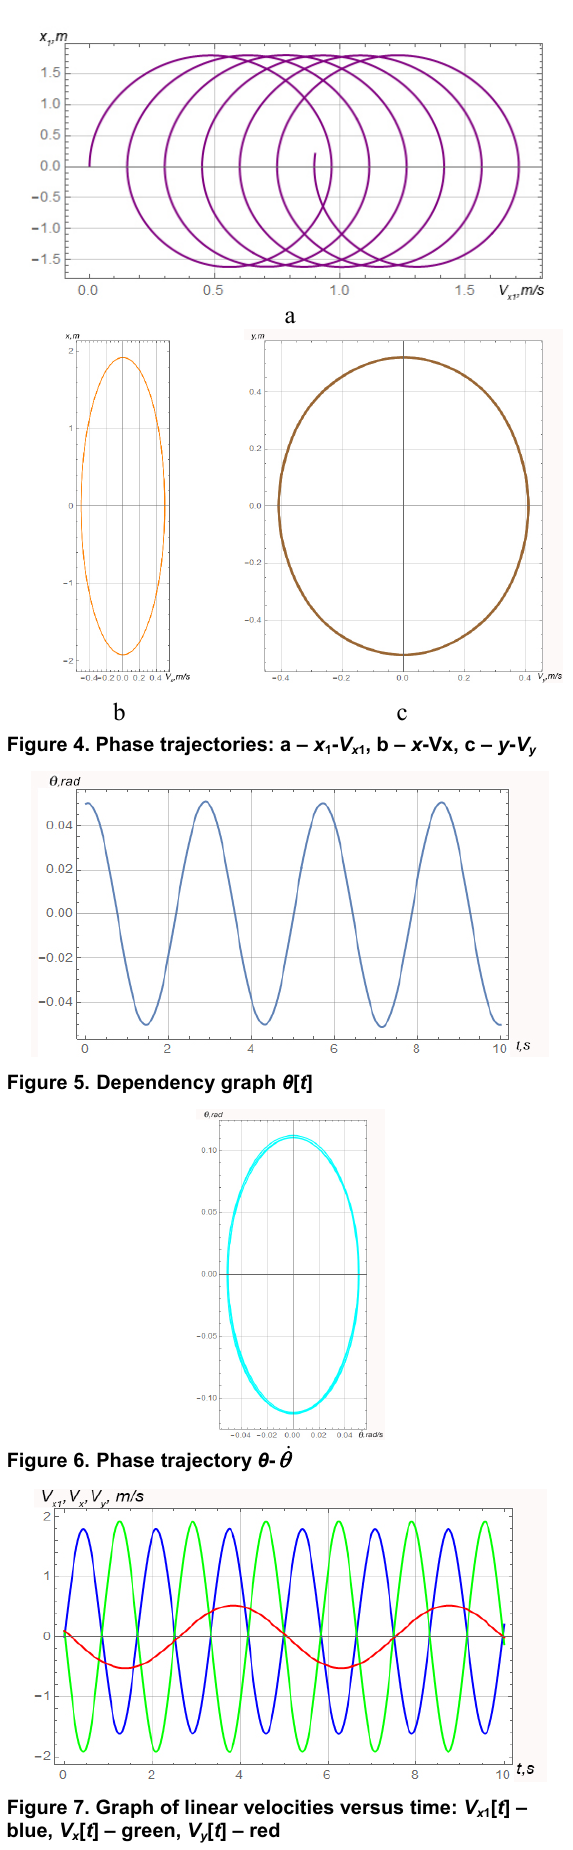
Figure 7. Graph of linear velocities versus time: V x 1 [ t ] – blue, V x [ t ] – green, V y [ t ] – red